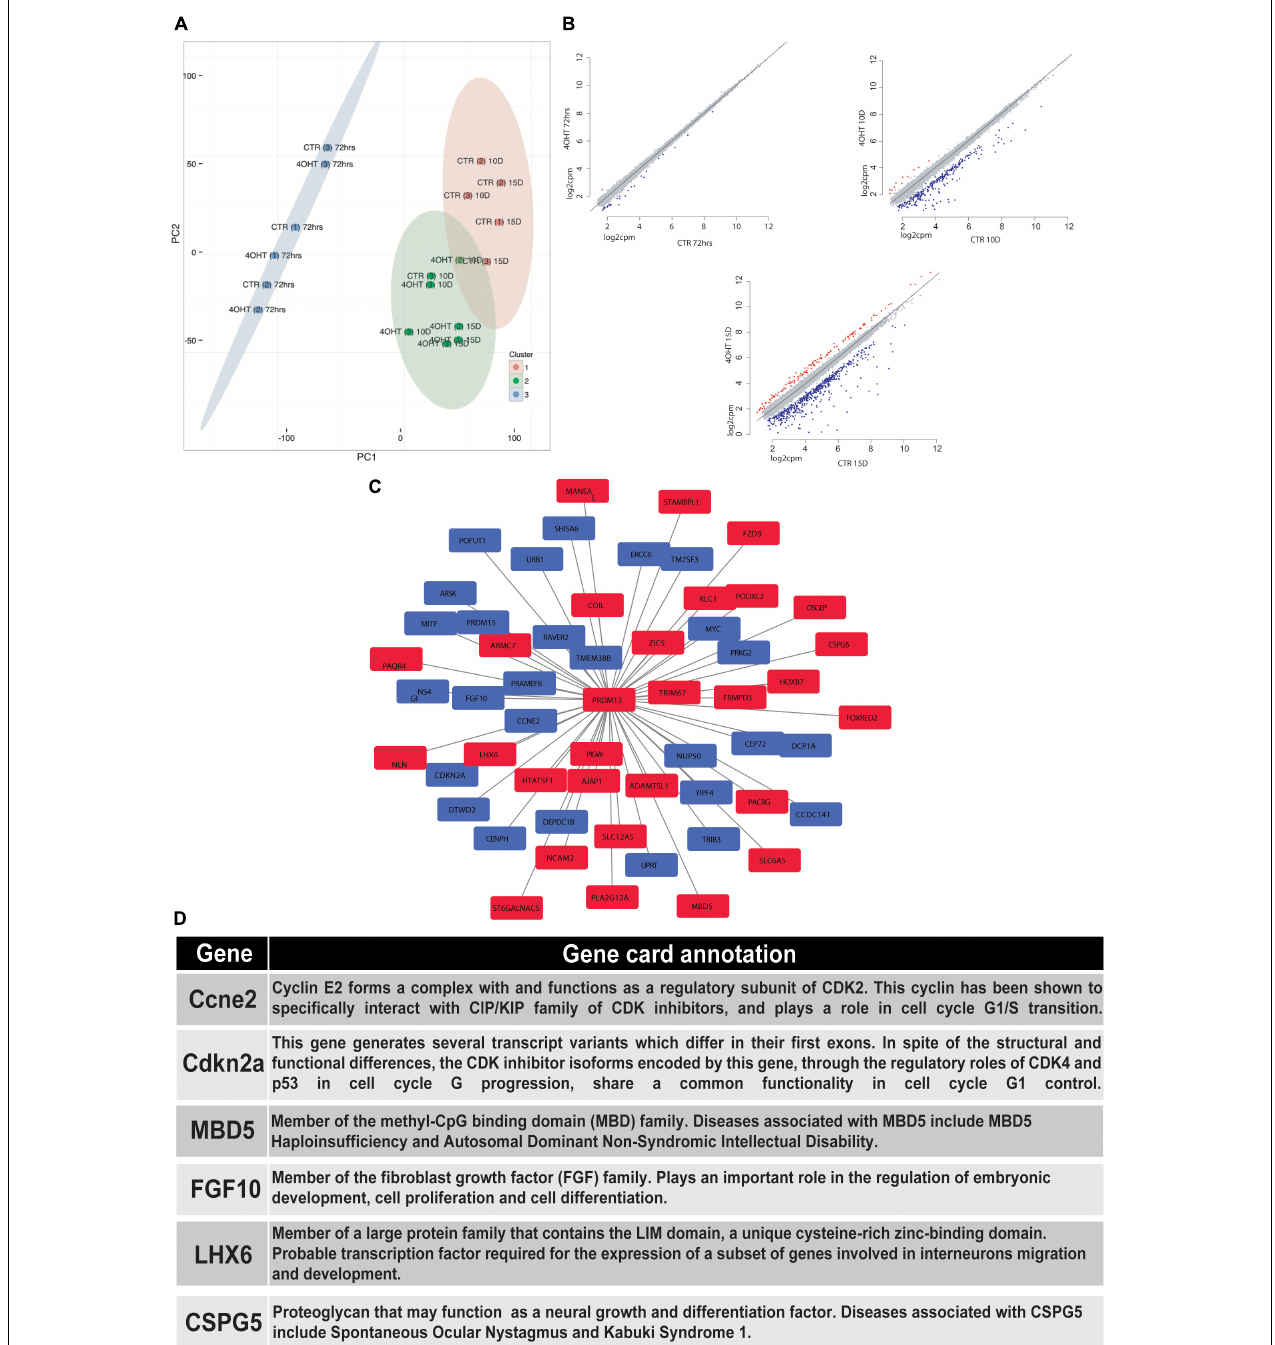
FIGURE 3 | EZH2-dependent transcriptional modulation converges with PRDM13 regulatory network. (A) Principal component analysis of 4-OHT and CTR samples at 72h, 10D and 15D after plating of neuronal progenitors based on gene expression. (B) Scatter plots showing differentially upregulated (red dots) and downregulated (blue dots) genes with fold change > 2 and FDR < 0.05 in 4-OHT samples at 72h, 10D and 15D after plating of neuronal progenitors; axes values correspond to log2cpm (counts per million reads) in CTR samples (x) and 4-OHTsamples (y). (C) PRDM13 regulatory network computed integrating 10D differential expression data with a co-expression network analysis performed using the GeneMania database (Warde-Farley et al., 2010). Red squares indicate genes with a concordant direction of expression as compared to Prdm13 whereas blue squares indicate genes with a discordant direction of expression as compared to Prdm13 (D) Gene card annotation and status in the differential expression analysis in 4-OHT10D samples of 6 relevant genes of the PRDM13 regulatory network depicted in Figure 3C .